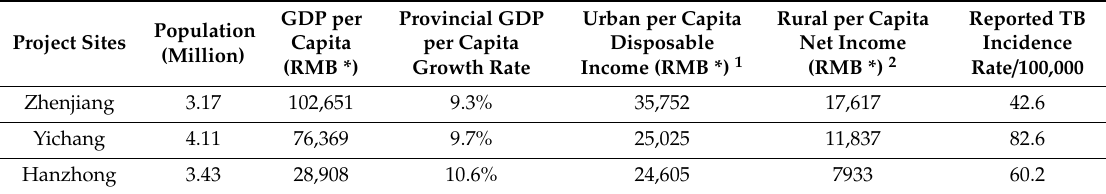
Table 1. Population, economic development, incomes, and tuberculosis burden of the three cities (2014). GDP per Population Project Sites (Million)